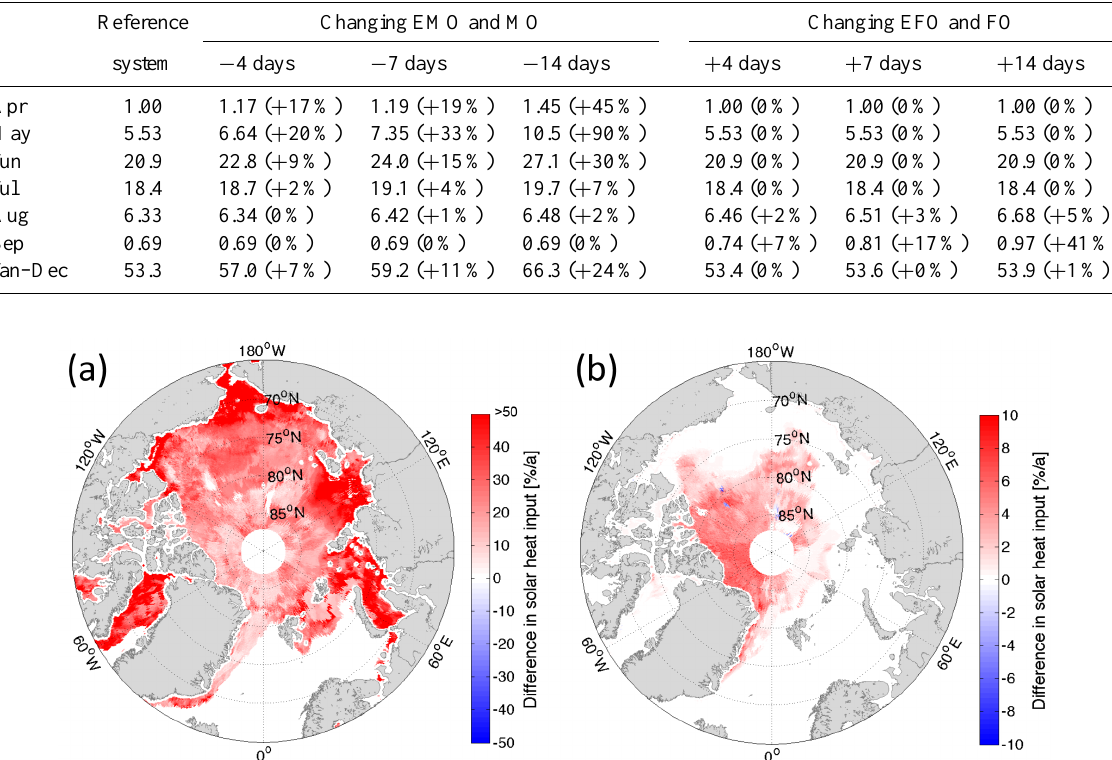
Table 3. Annual Arctic-wide solar heat input (and relative changes) under sea ice ( Q T ) in 2011 for the reference method and sensitivity study 1: changes in melt season duration by a shift of 4 days (data uncertainty, Markus et al., 2009), 7 days (estimated uncertainty due to the only weekly sea ice age data by Maslanik et al., 2011), and 14 days (derived from comparisons to field data; Nicolaus et al., 2010a). All trends were only performed towards a prolongation of the melt season. All numbers are in 10 19 J.